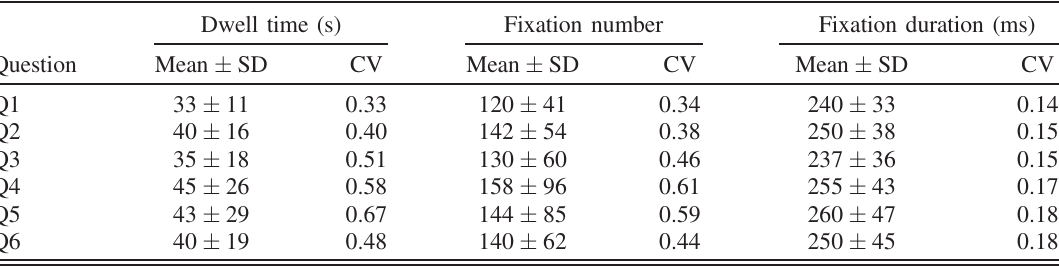
TABLE II. Mean, standard deviation (SD) and coefficient of variation (CV) of total dwell time, total fixation number, and average fixation duration for each